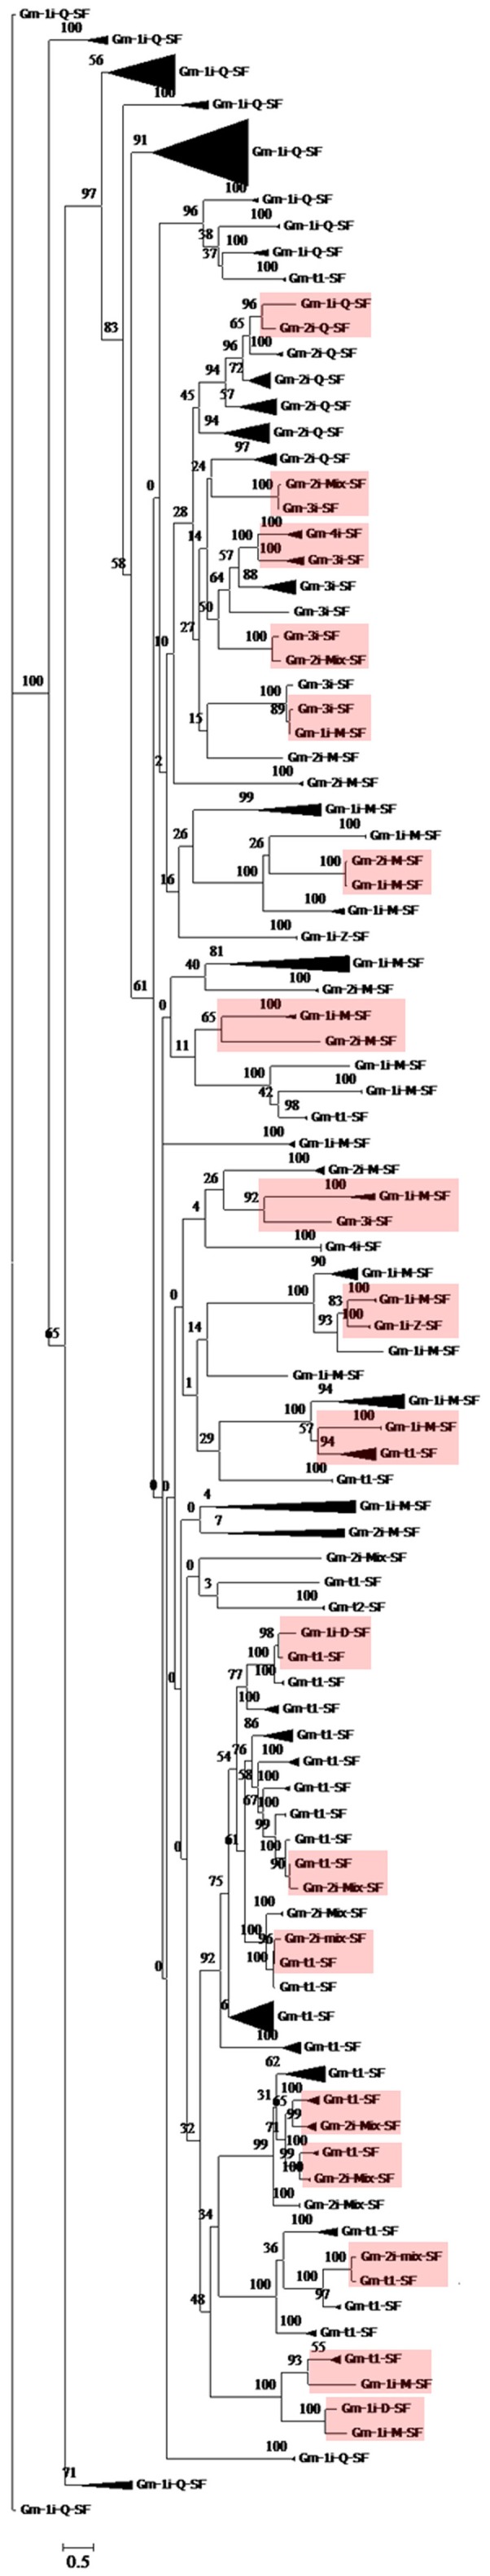
Phylogenetic analysis of the classified soybean C2H2-ZF genes. Firstly, neighbor-joining phylogenetic tree of the 321 soybean C2H2-ZFPs was constructed using MEGA6 by the neighbor-joining method with 1,000 bootstrap replicates; then classified the subset of each C2H2-ZF gene and compressed the subtree of the neighbor-joining phylogenetic tree to construct a phylogenetic tree of the 11 classified soybean C2H2-ZFP subsets. The low bootstrap supports of some main branches indicated that a high degree of complexity was existed in different soybean C2H2-ZFPs subsets. Most of the same subset C2H2-ZFPs was clustered together and had more than 50% bootstrap support. RGB background indicated 18 small branches with different subsets had significant bootstrap support (>50%).